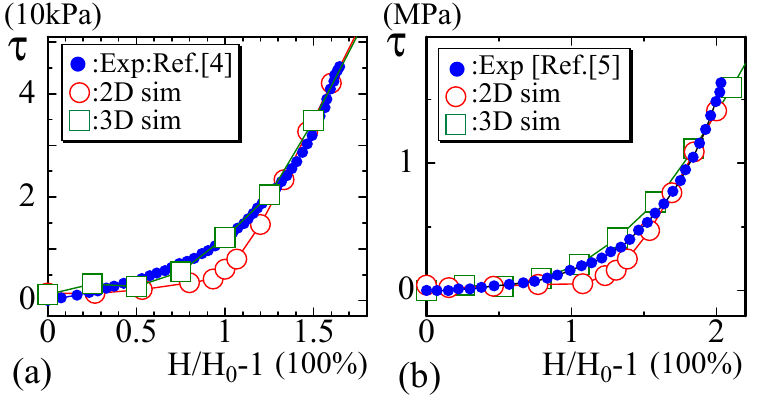
Figure 7. The experimental diagrams of soft biological materials such as ( a ) skin and ( b ) arteries reported in [6,7]. These experimental data are examples of diagrams with an L-heel, and the 2D simulation data slightly deviate from the experimental data in both ( a ) and ( b